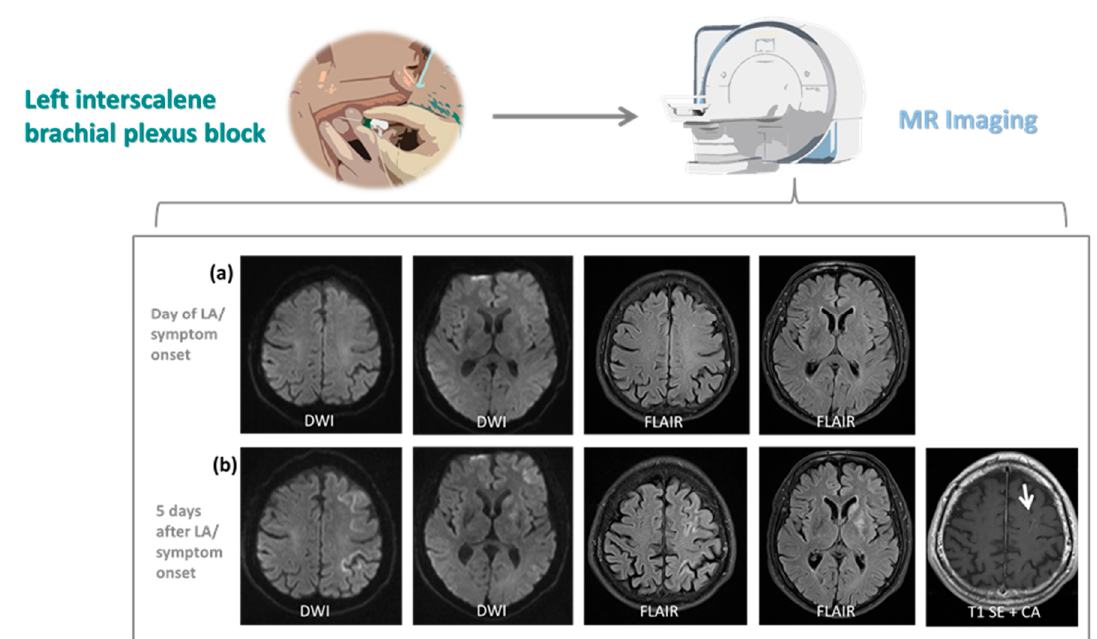
Figure 2. Magnetic resonance imaging (MRI) results of patient 3 admitted to the neurological intensive care unit with suspected stroke following interscalene brachial plexus block (ISB). ( a ) Diffusion-weighted imaging (DWI) and fluid- attenuated inversion recovery (FLAIR) sequence as part of the standard MRI screening protocol used for patients with suspected stroke (DWI/ADC, T2 TSE, FLAIR, T2*, arterial TOF-MR-angiography) does not reveal cerebral lesions on the day of local anesthesia (LA) and symptom onset. ( b ) Five days after LA, DWI shows restricted diffusion with corresponding FLAIR hyperintensities in the basal ganglia, including caudate nucleus, putamen and globus pallidus, as well as cerebral cortex of the frontal and medial superior gyrus, and central and post central gyrus of the left hemisphere. Diffuse cortical enhancement (arrow) in the left frontal lobe is detected in contrast-enhanced T1-weighted MRI. All examinations were performed on a 3 T whole-body magnetic resonance system (MAGNETOM Skyra; Siemens Healthcare, Erlangen, Ger- many).